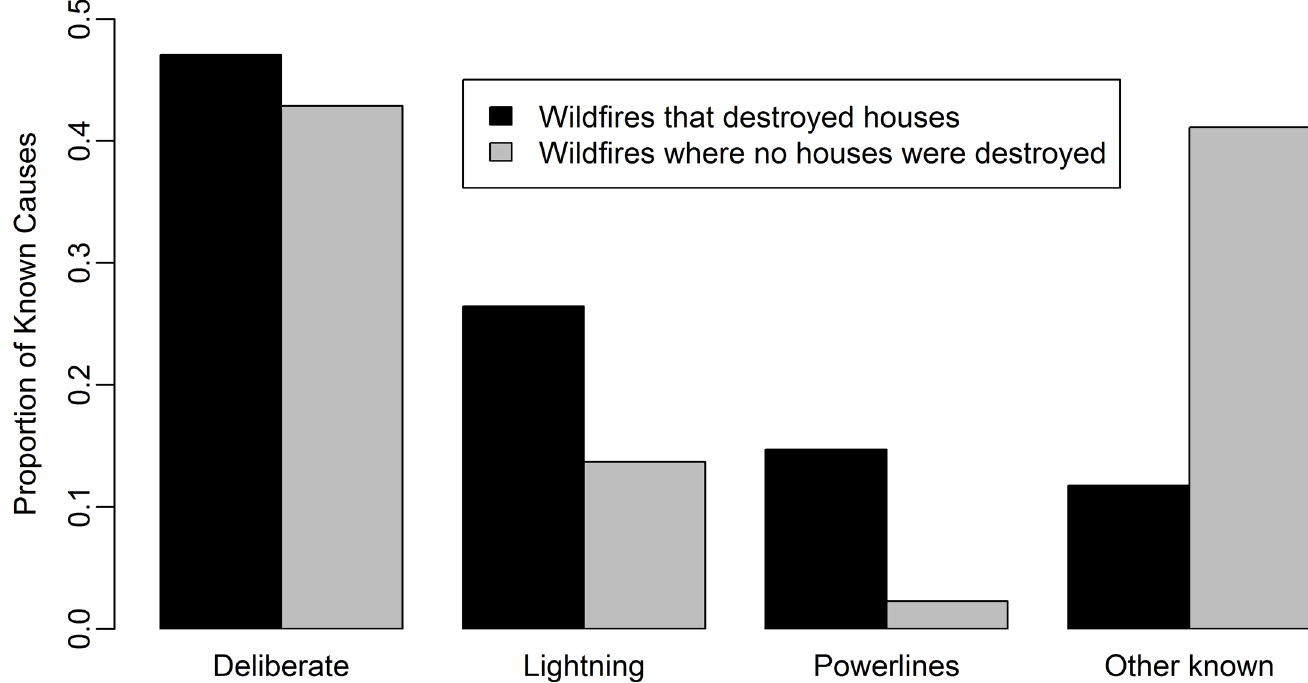
Fig 6. The proportion of wildfires that destroyed houses (n = 58) and wildfires where no houses were destroyed (n = 87055) by known cause for the 12 years with complementary